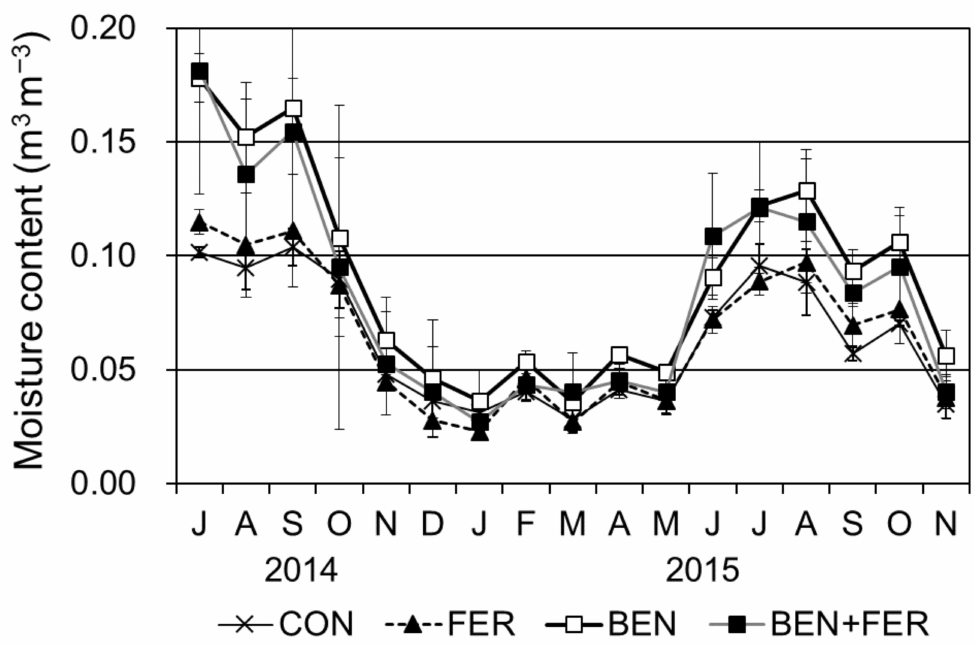
Figure 1. Average soil moisture content in the six treatments (July 2014–November 2015, mean ± SE, n = 2). Note: Average Data for the CON treatment were from Kayama et al. [15]. The data for